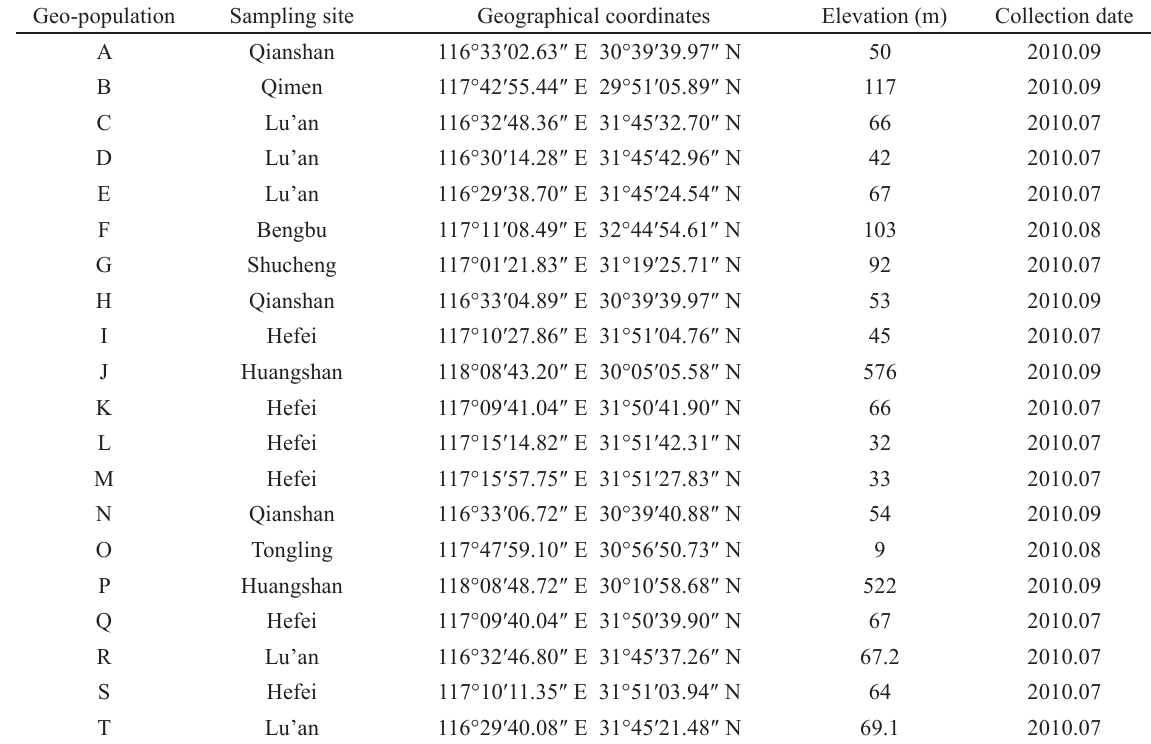
Table 1 . Collection data of geo-populations of O. formosanus .